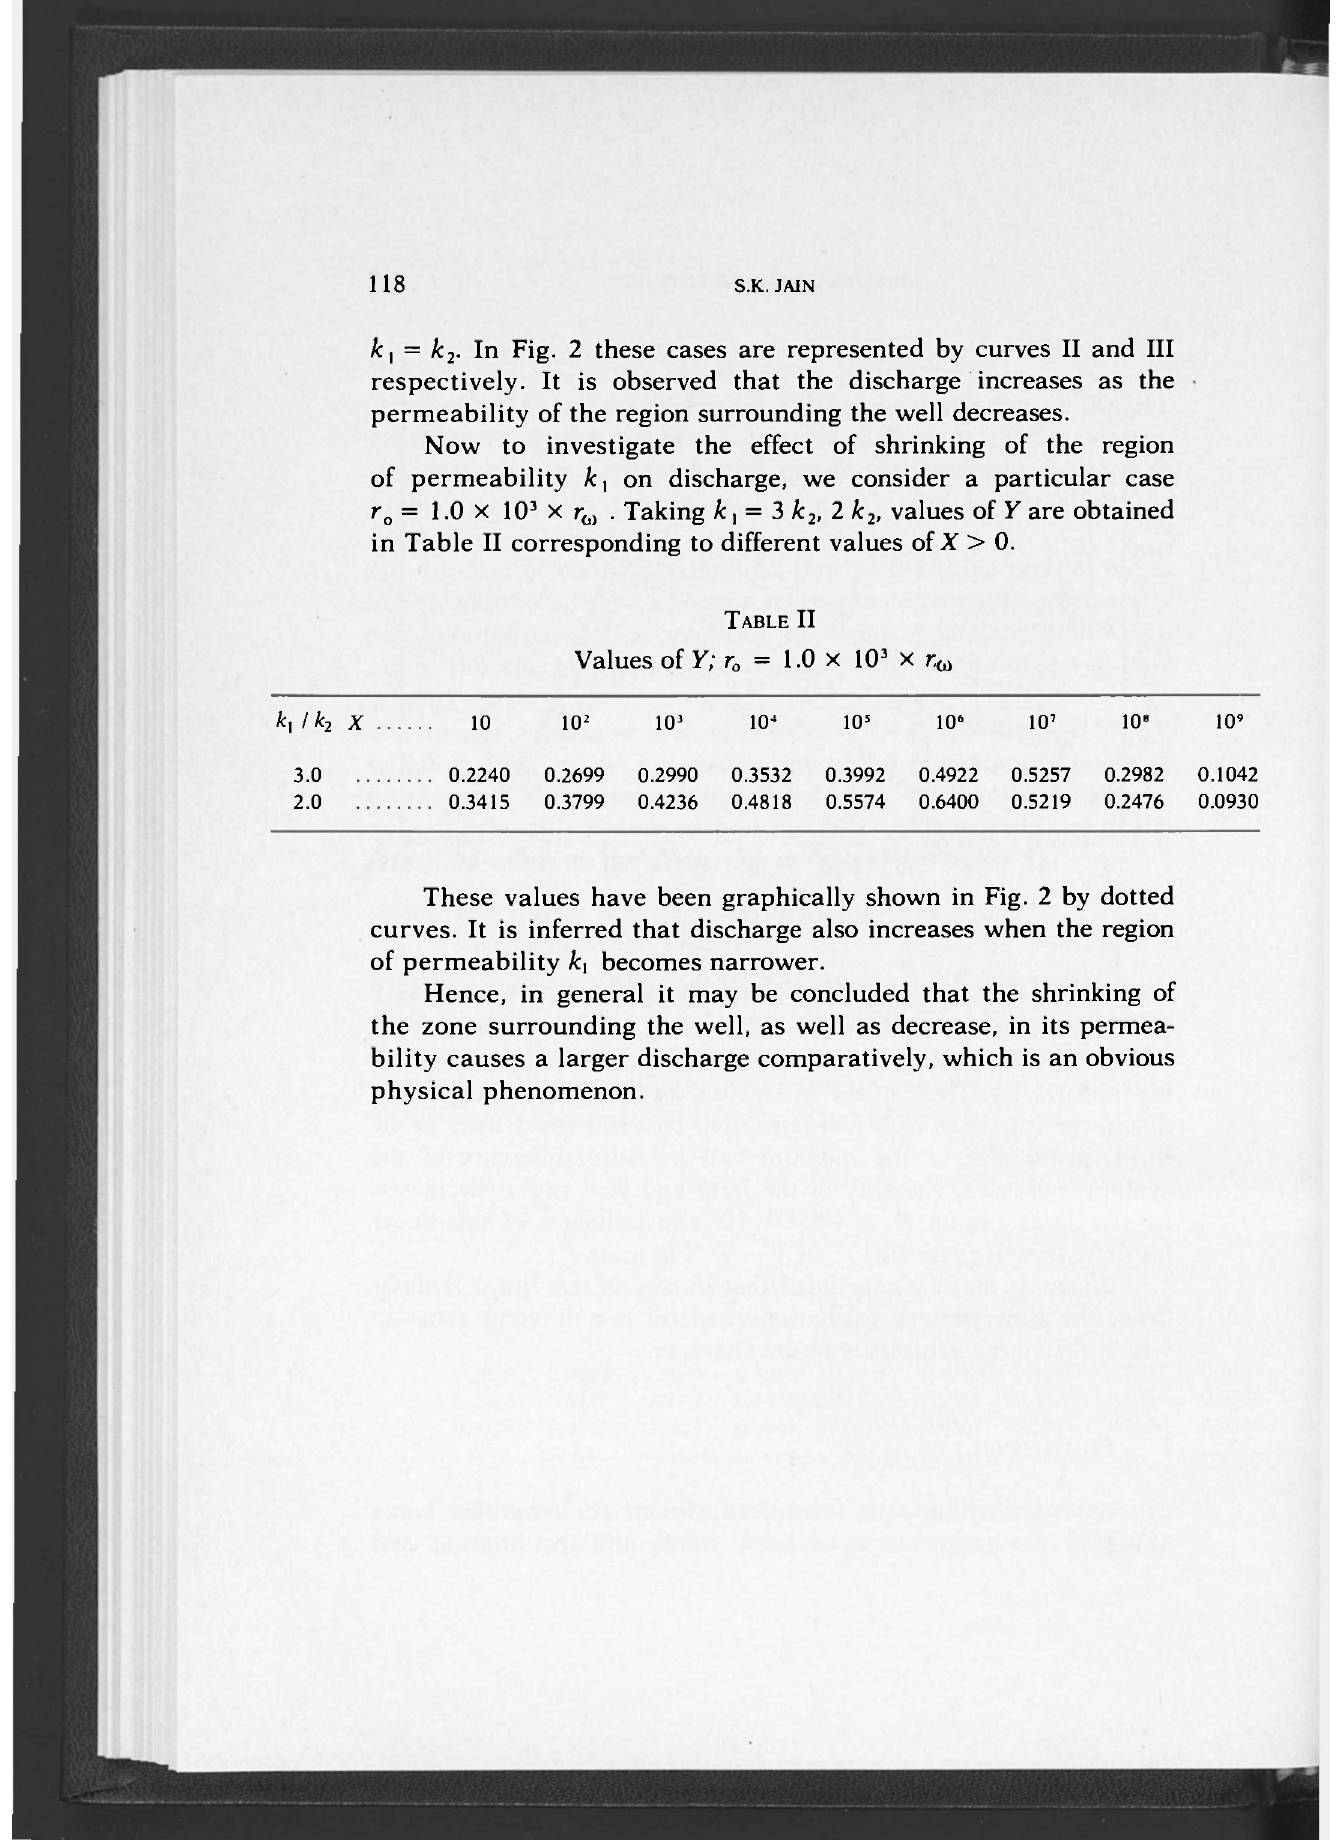
k = k . In Fig. 2 these cases are represented by curves II and III t 2 respectively. It is observed that the discharge increases as the permeability of the region surrounding the well